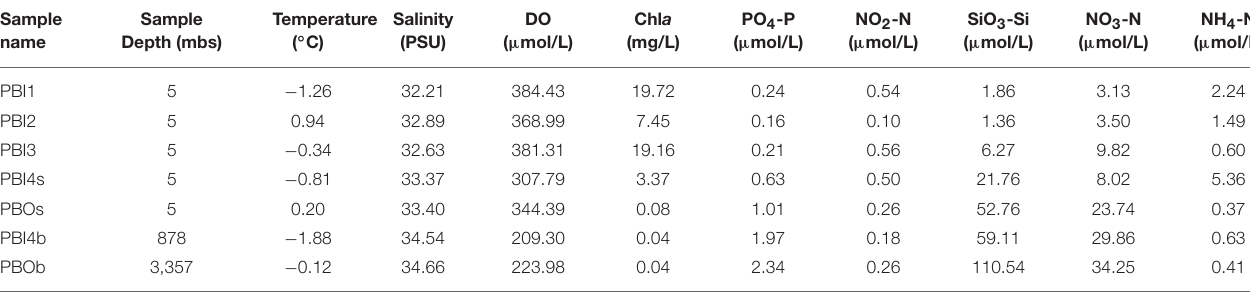
TABLE 1 | Main environmental factors of seven viral metagenomic samples in the Prydz